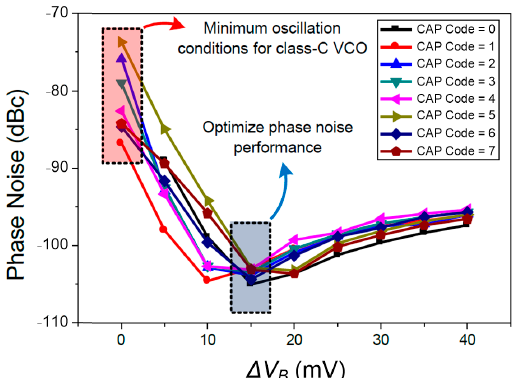
Figure 3. This figure is the simulation result of phase noise at 1 MHz offset frequency for the gate bias variation ( Δ V B ) from the lowest oscillation voltage of the proposed class-C VCO core